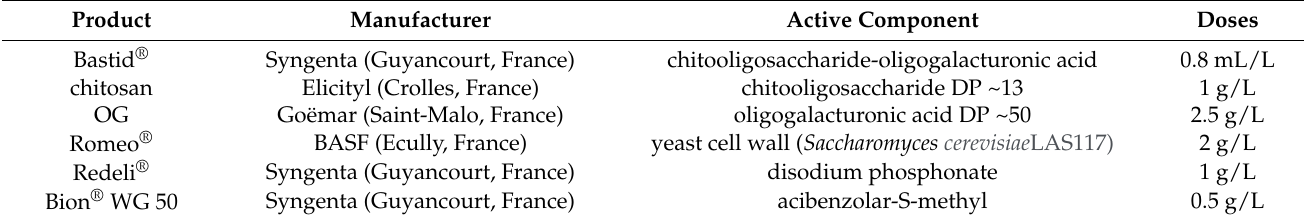
Table 3. Elicitors and doses used in the study. DP: degree of